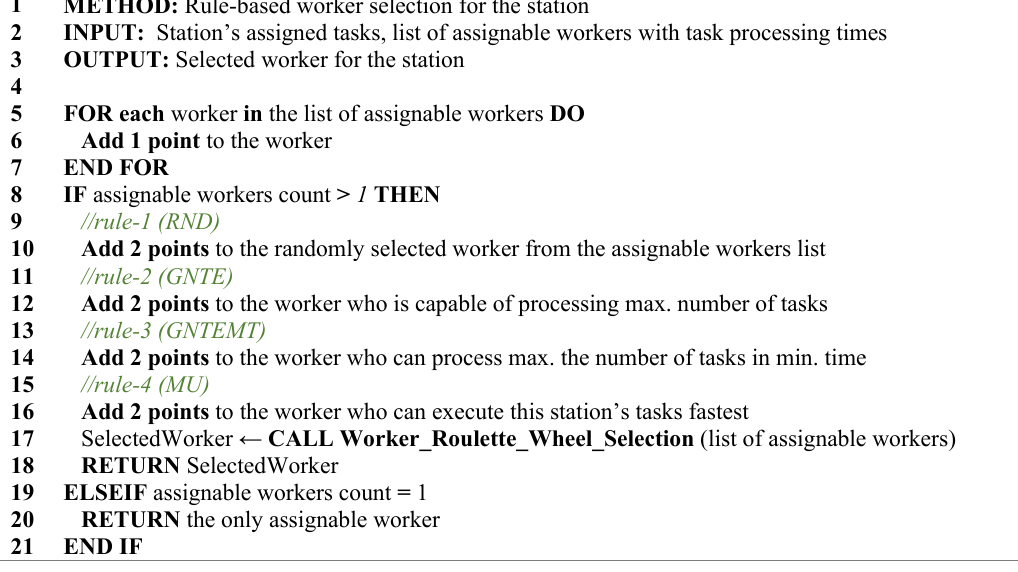
Algorithm 2: The rule-based worker selection